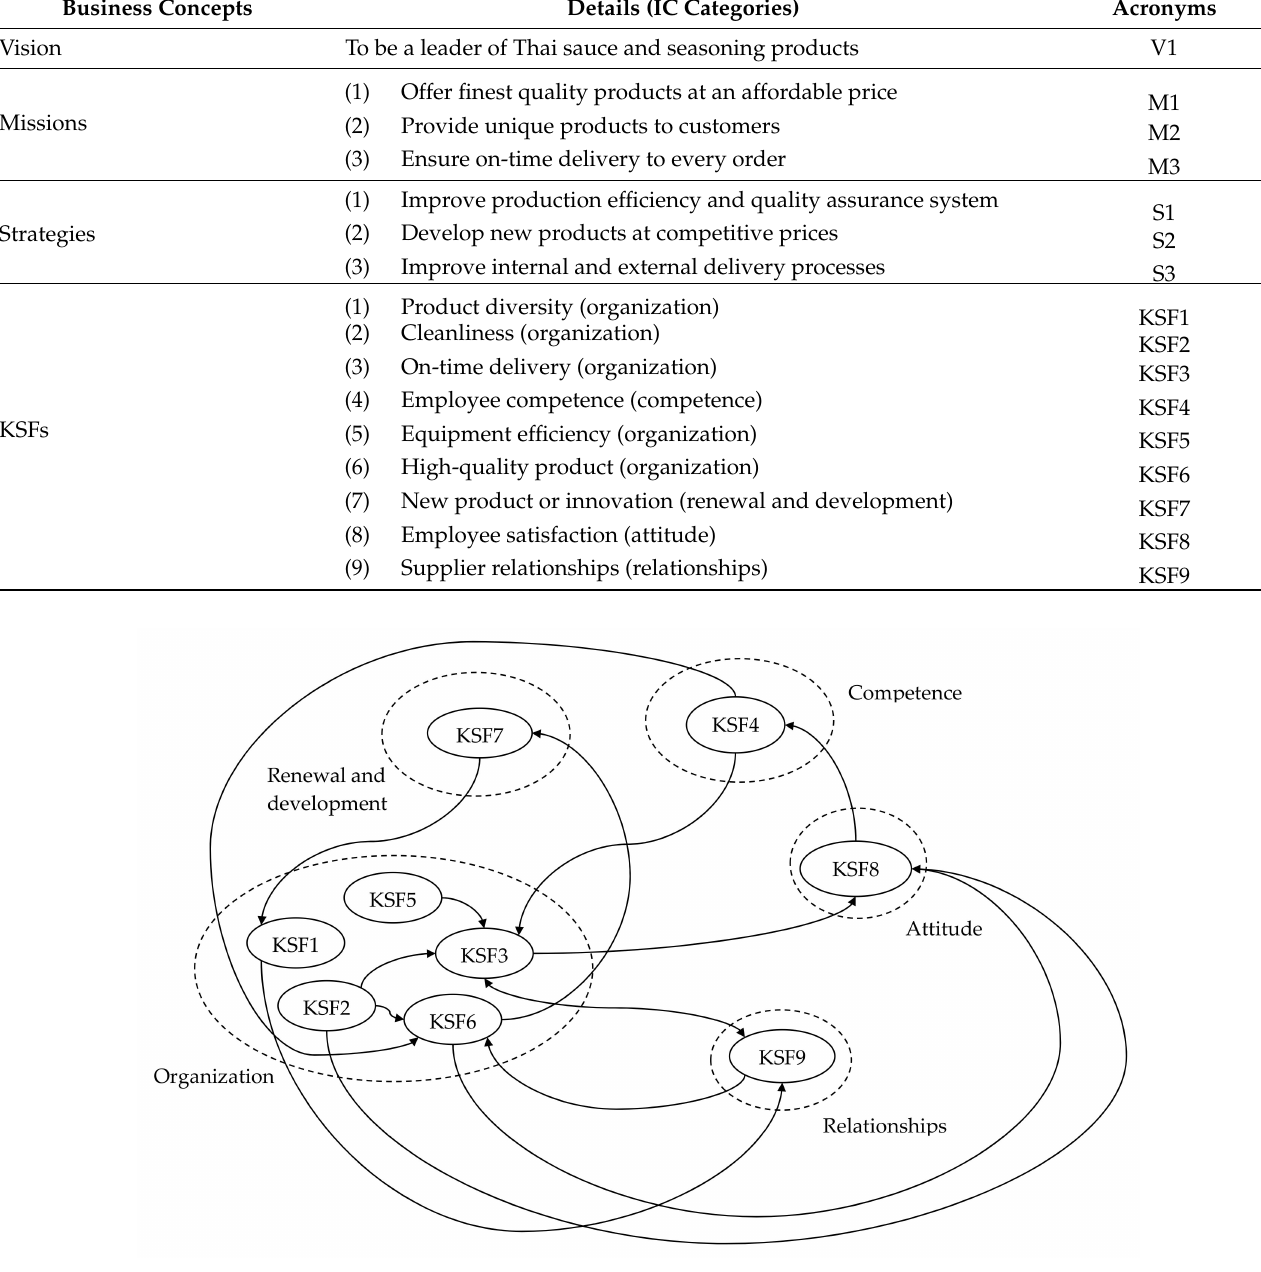
Figure 3. A network model of food factory